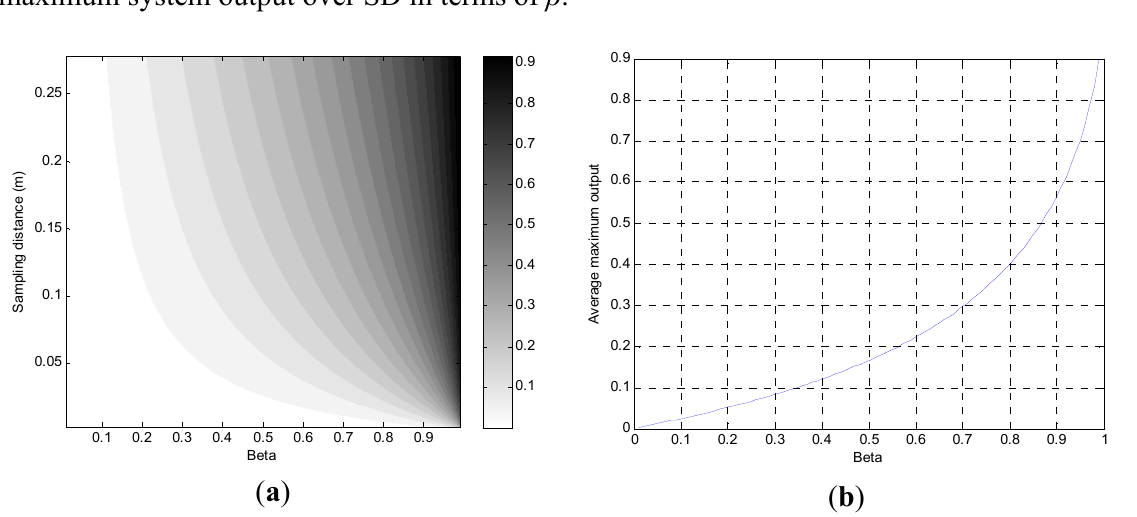
Figure 8. ( a ) Maximum system output distribution in terms of β and SD; ( b ) Averaged maximum system output over SD in terms of β